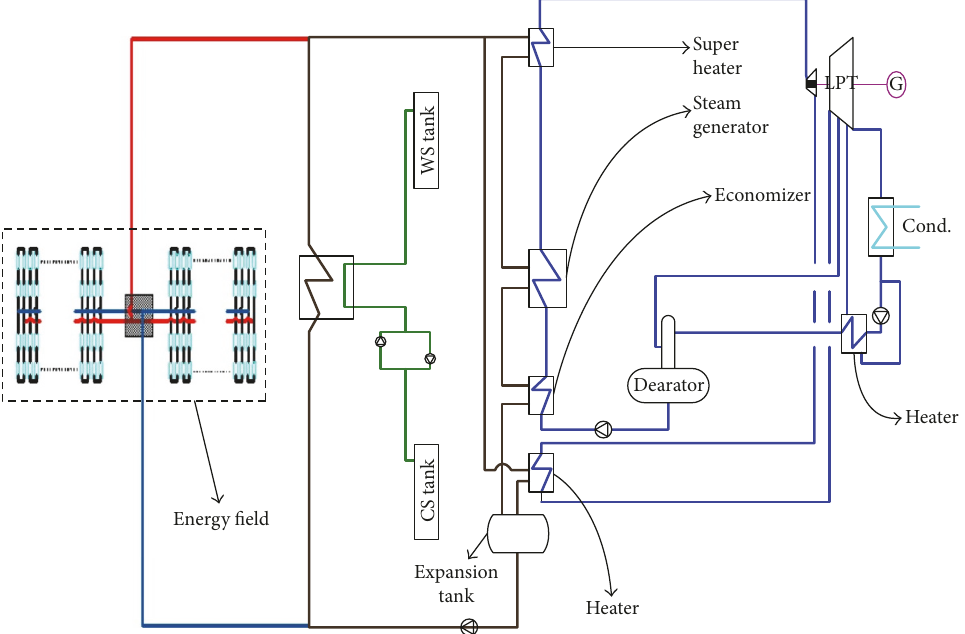
Figure 1: Diagram of the solar power